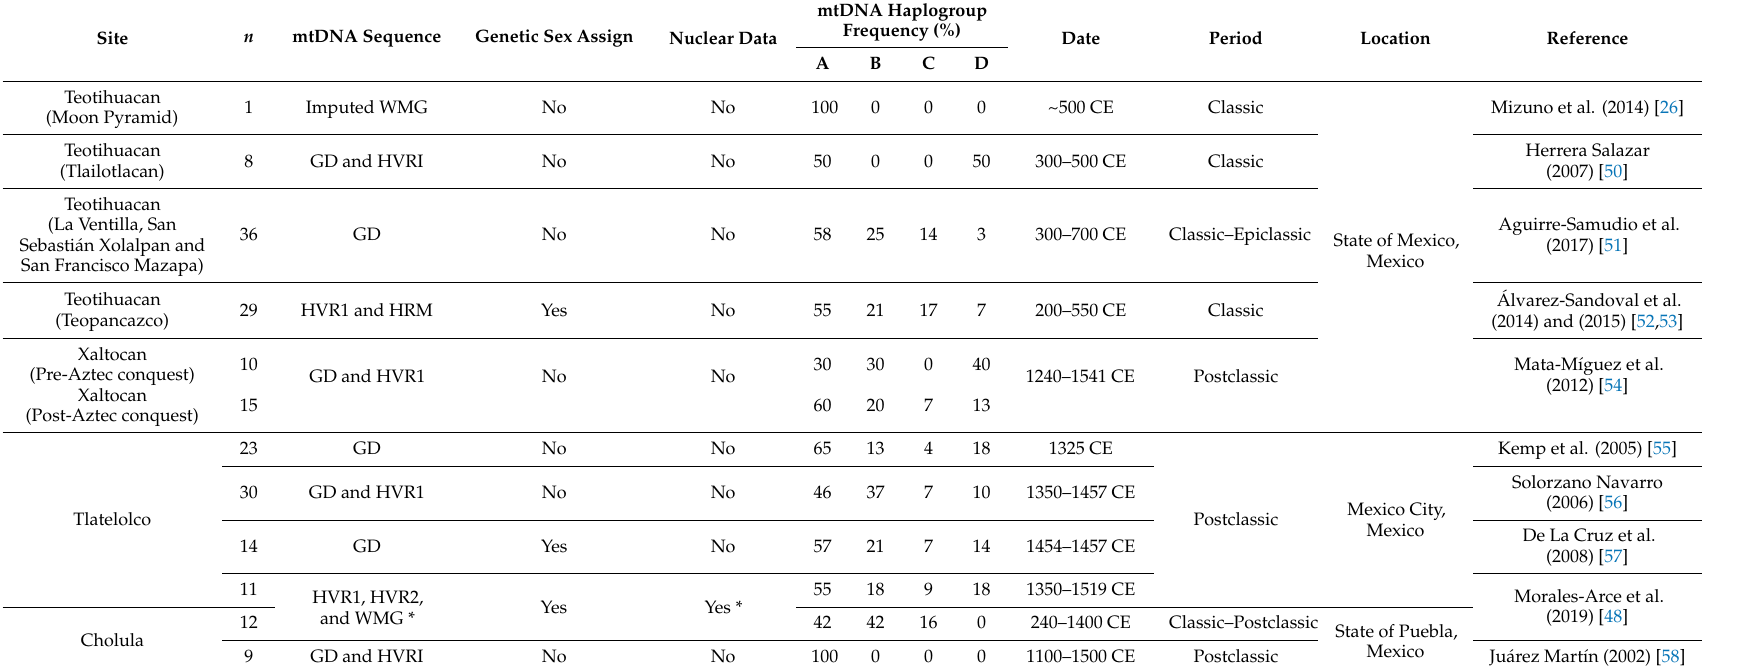
Table 2. Ancient DNA studies in the Basin of